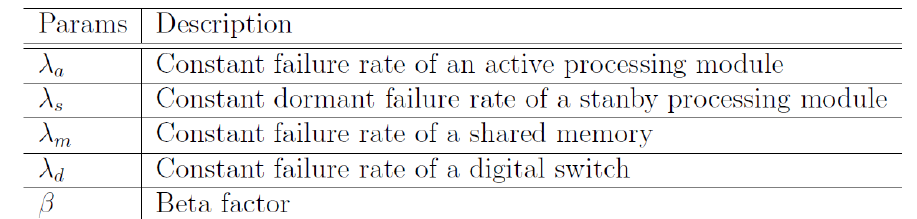
Table 2. Model parameters